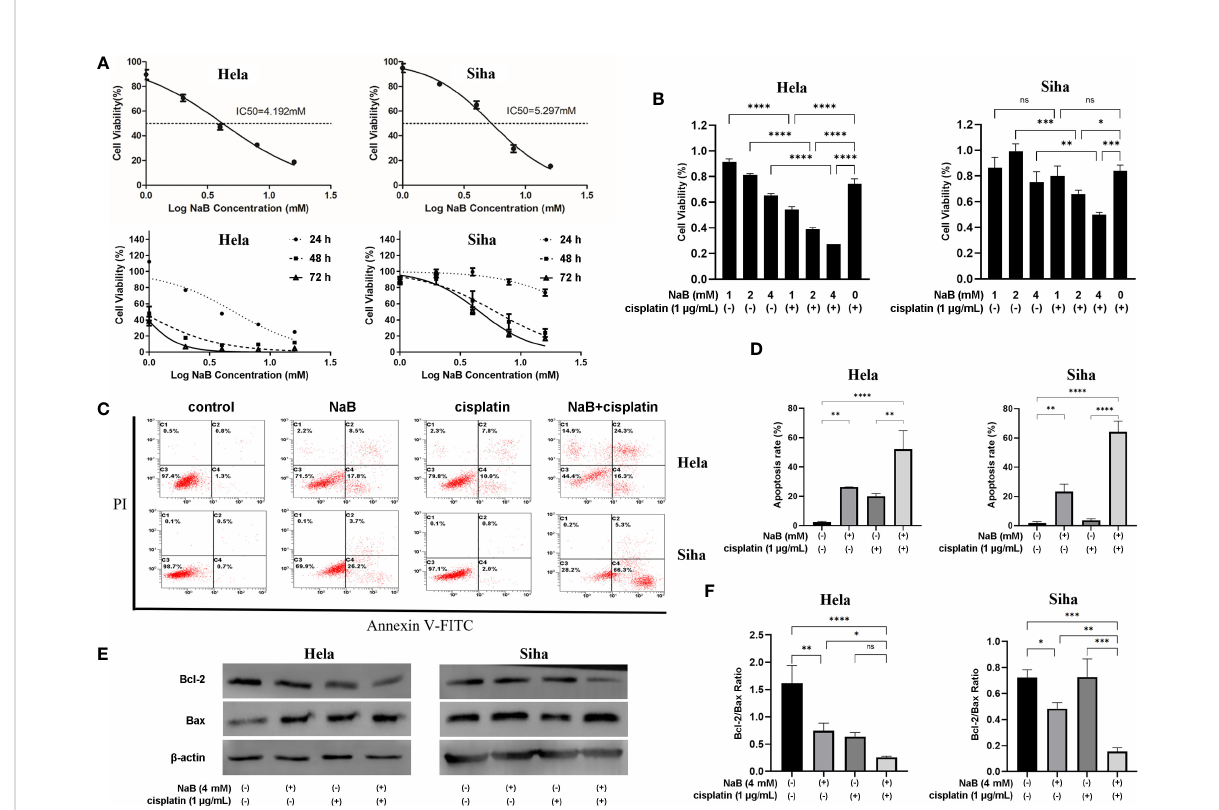
FIGURE 1 NaB combined with cisplatin inhibited the cell viability of Hela and Siha cells through promoting their apoptosis. (A) Cell viability was detected 24 h, 48 h and 72 h after Hela and Siha cells were treated with NaB (1, 2, 4, 8 and 16 mM). (B) The viability of Hela and Siha cells was examined after the treatment with NaB (1, 2, and 4 mM) alone or in combination with cisplatin (1 m g/mL). (C) Annexin V-FITC- and PI- stained cells were detected by fl ow cytometer, and (D) apoptosis rates of Hela and Siha cells are quantitatively shown. (E, F) Protein bands of Bcl-2, Bax and b -actin (internal control) were visualized by Western blot and the expression was quantitatively presented. Hela cells were examined 24 h and Siha cells were examined 48 h after the treatment with NaB (4 mM) alone or in combination with cisplatin (1 m g/mL) (B – F) . Data represent the mean + standard deviation from 3 independent experiments. Signi fi cance was examined by one-way ANNOVA ( ns P>0.05, *P<0.05, **P<0.01, ***P<0.001, ****P<0.0001). NaB, sodium butyrate; FITC, fl uorescein isothiocyanate; PI, propidium